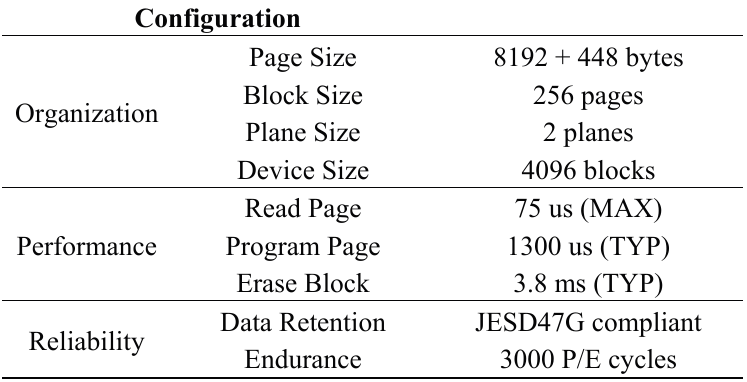
Table 2. Configuration of the Micron 29F64GCBAAA NAND flash